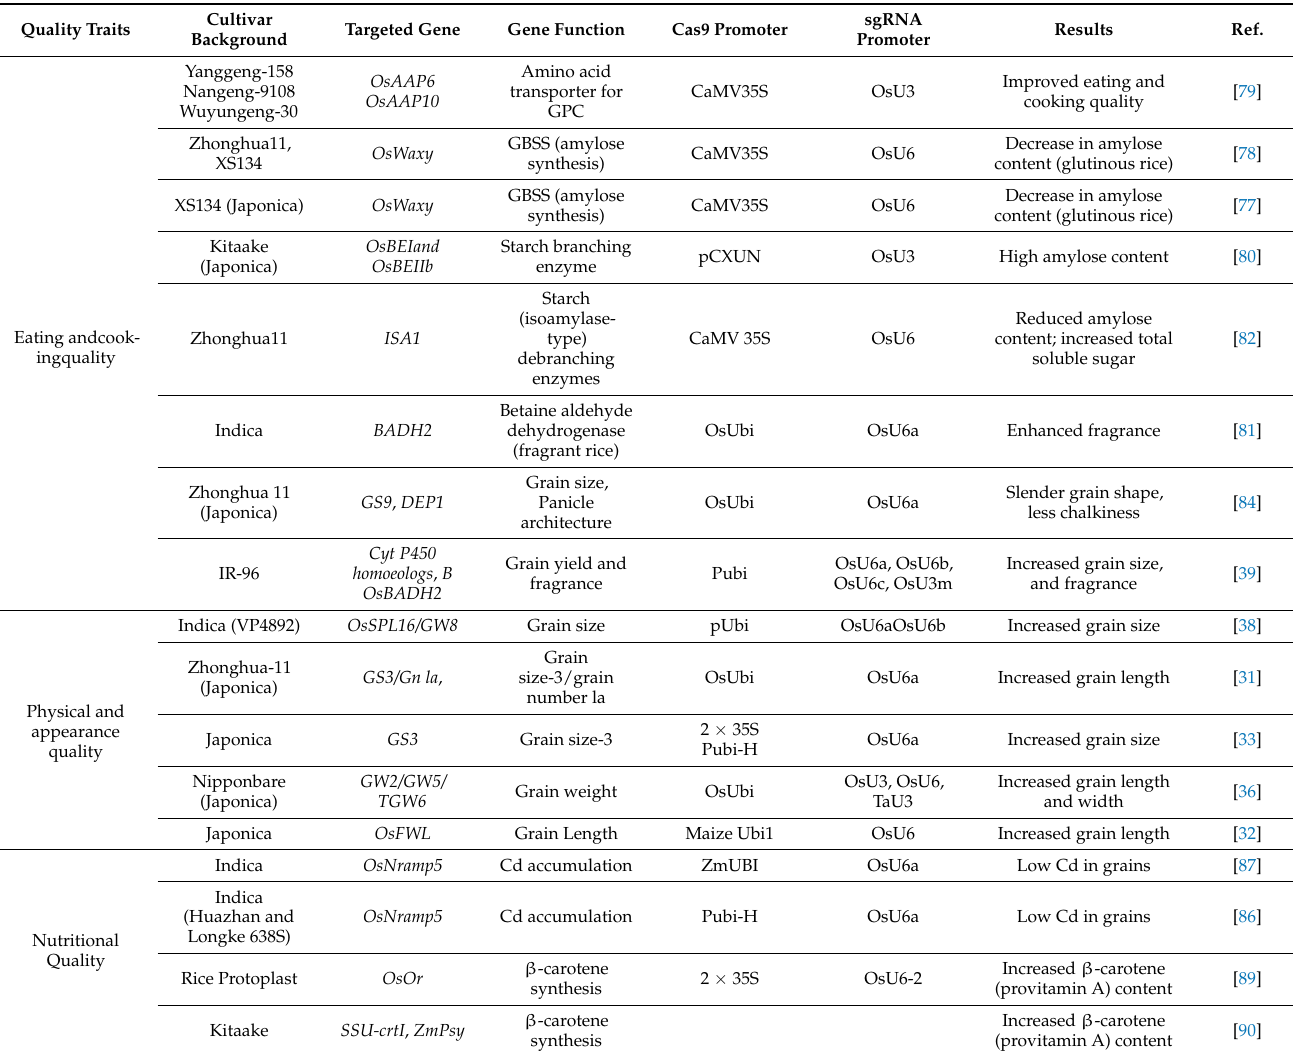
Table 4. Key applications of CRISPR/Cas9 system for improving rice grain